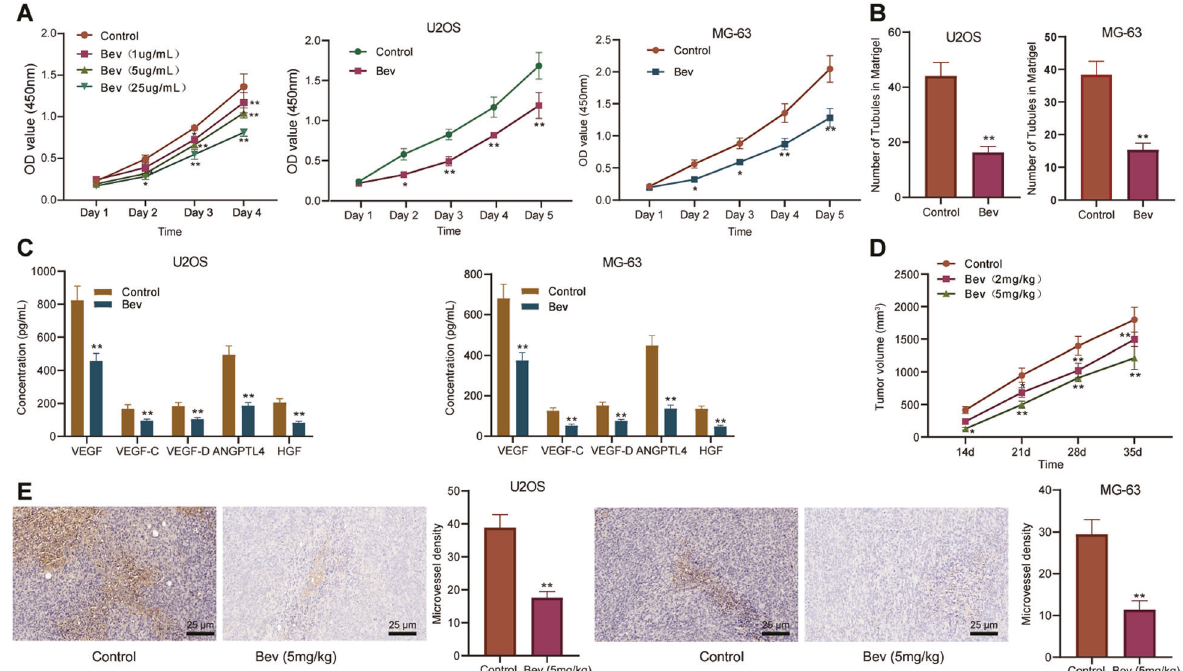
Fig. 1 Bev represses the proliferation and angiogenesis of osteosarcoma cells in vitro and in vivo. A Proliferation of U2OS and MG63 cells treated with Bev at concentrations of 1, 5, and 25 mg/mL measured by CCK-8 assay. B Angiogenesis of Bev-treated U2OS and MG63 cells measured by microtubule formation in vitro. C ELISA detection of levels of angiogenesis-related genes HGF, VEGF-D, VEGF-C, VEGF, and ANGPTL4 in the supernatant of Bev-treated U2OS and MG63 cells. D Tumor volume of mice treated with Bev. E MVD in tumor tissues of mice treated with Bev was detected by IHC (scale bar: 25 μ m). * p < 0.05, compared with control cells; ** p < 0.01, compared with control mice. n = 6 for mice upon each treatment. All experiments were conducted three times